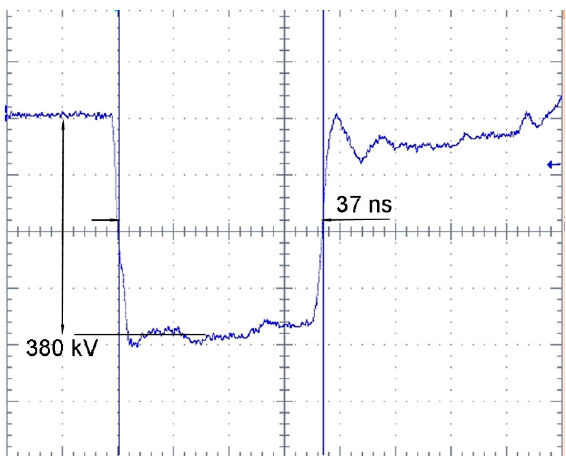
Figure 12. Voltage waveform across resistive load for TWFL charged to − 650 kV (time base 10 ns/div).